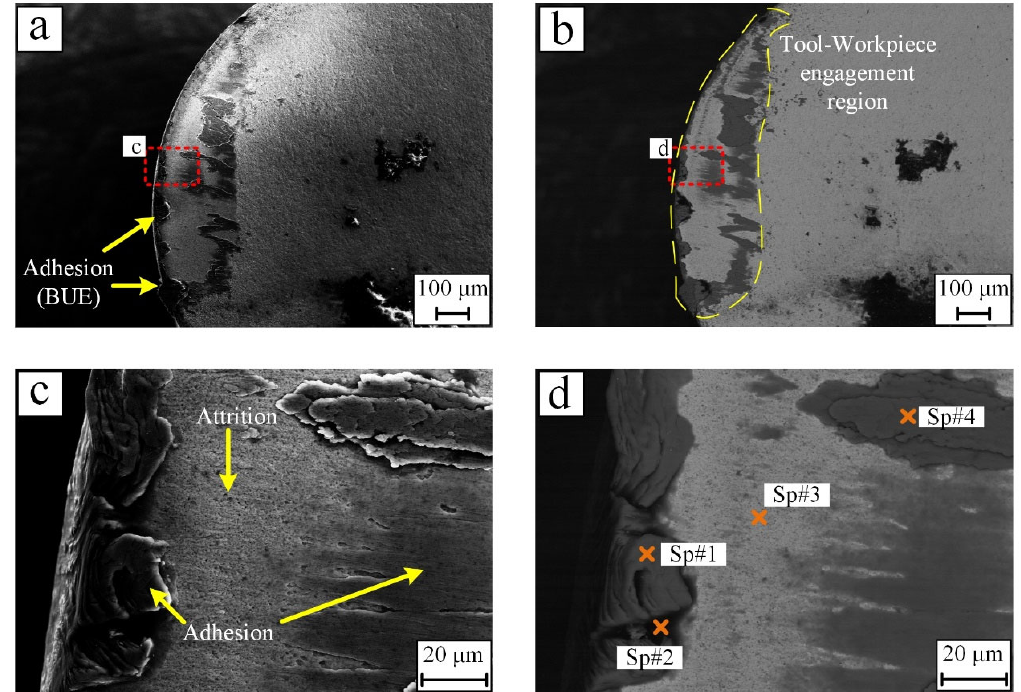
Figure 19. The worn inserts after machining wrought titanium tubes at a cutting depth of 0.5 mm: ( a ) secondary electron image showing the overview of the worn area, ( b ) backscatter electron image highlighting tool ‐ workpiece contact area, ( c ) enlarged area of shown in ( a ), and ( d ) enlarged area shown in ( b ). Table 8. EDS Spectral analysis of locations identified in Figure 19d.